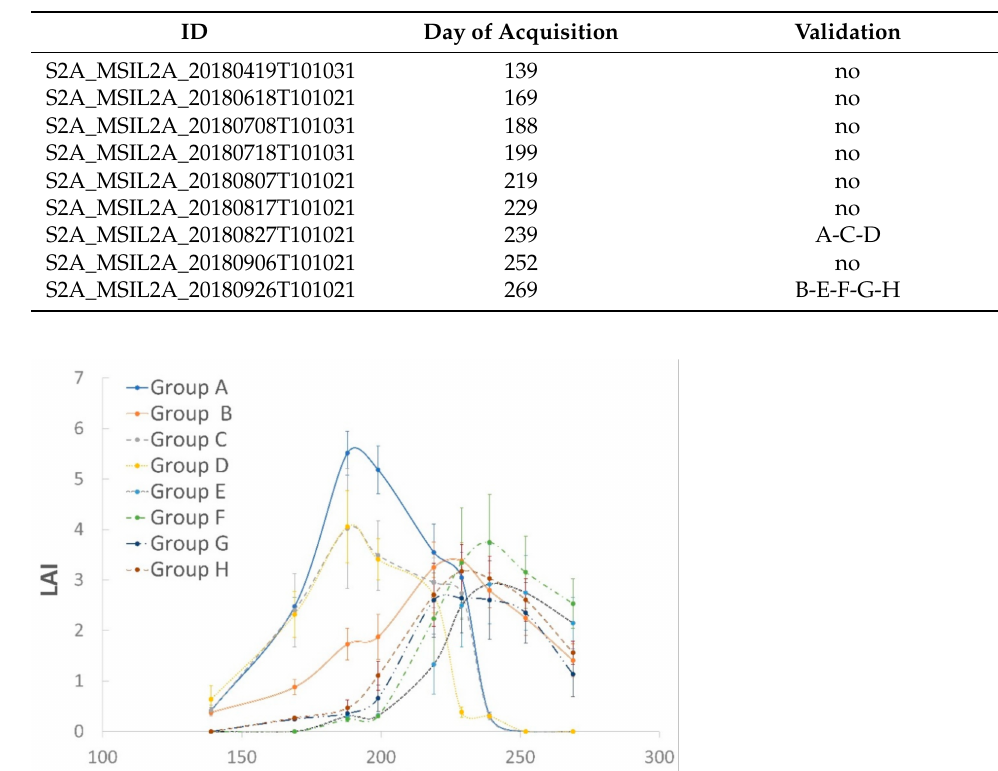
Table 2. List of Sentinel-2 Level 2 images used for this study and their day of acquisition (column 2). In the column called Validation, the images classified as “no” were used for the assimilation, while the images classified with capital letters were used to validate the results of the group of fields corresponding to the latter.